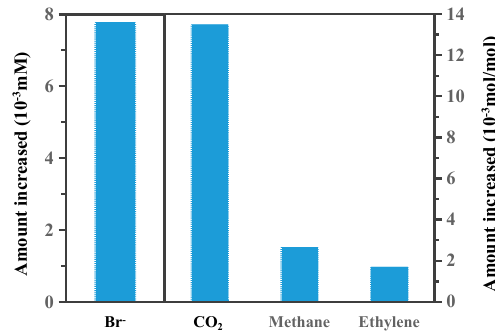
Figure 5. By-products of EDB biodegradation by the acclimated microbial consortium.